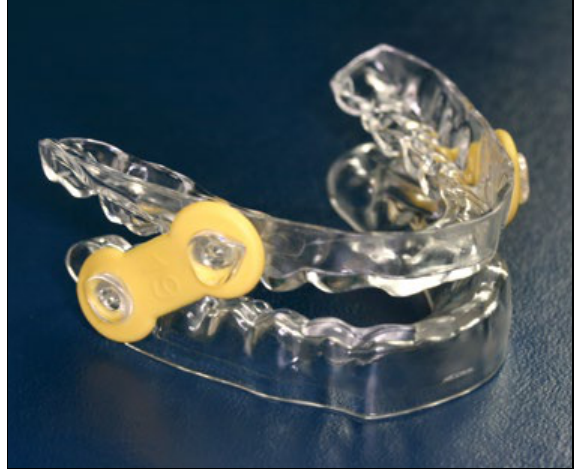
Figure 1. EMA Appliance.